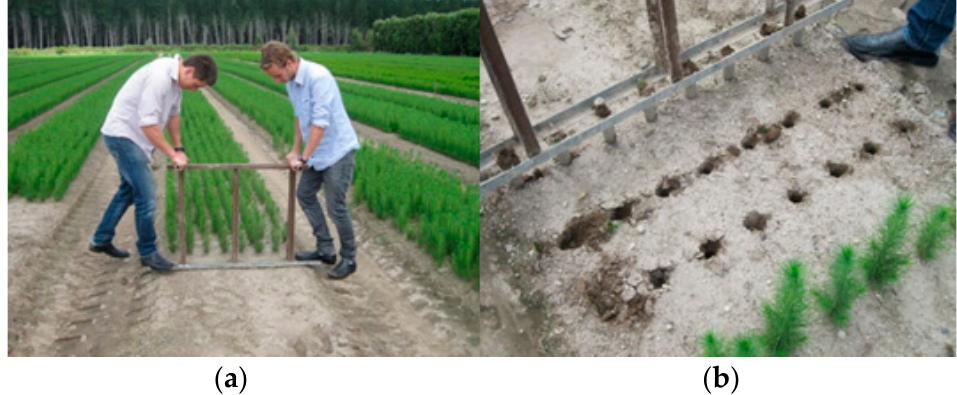
Figure 3. Manual dibbling process. ( a ) Dibbling manually; ( b ) Manually dibbled holes.